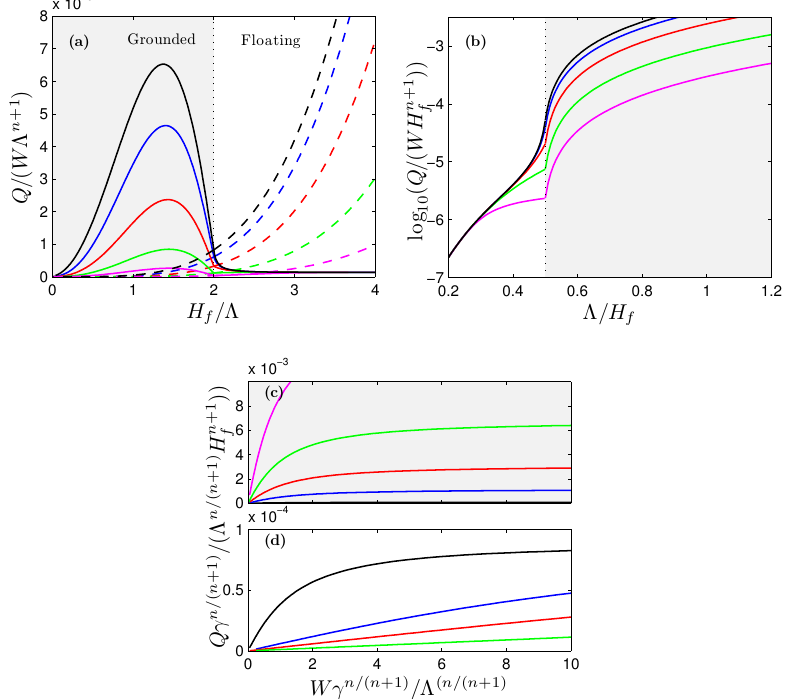
Figure 5. Solutions of the boundary layer problem. r = 0 . 9; n = 1 /m = 3. Dashed lines represent the FL law, solid lines the CD calving law. Grey shading indicates a grounded calving front in the CD model, and the white background a floating shelf. (a) Normalized flux against normalized thickness at different basal friction parameter values, (cid:48)W (n + 1 )/n /(cid:51) = 0 (black line), 1 (blue), 5 (red), 25 (green) and 125 (magenta). (b) Logarithm of normalized flux against normalized calving parameter at different basal friction parameter values, (cid:48)W (n + 1 )/n /H f = 0 (black line), 1 (blue), 5 (red), 25 (green) and 125 (magenta). (c) Normalized flux against normalized channel width at different (grounded) ice thickness: H f /(cid:51) = 2 (black), 5 / 3 (blue), 4 / 3 (red), 1 (green) and 2 / 3 (magenta). (d) Same as panel (c) but with floating ice thickness values H f /(cid:51) = 2 (black), 7 / 3 (blue), 8 / 3 (red) and 10 / 3 (green).